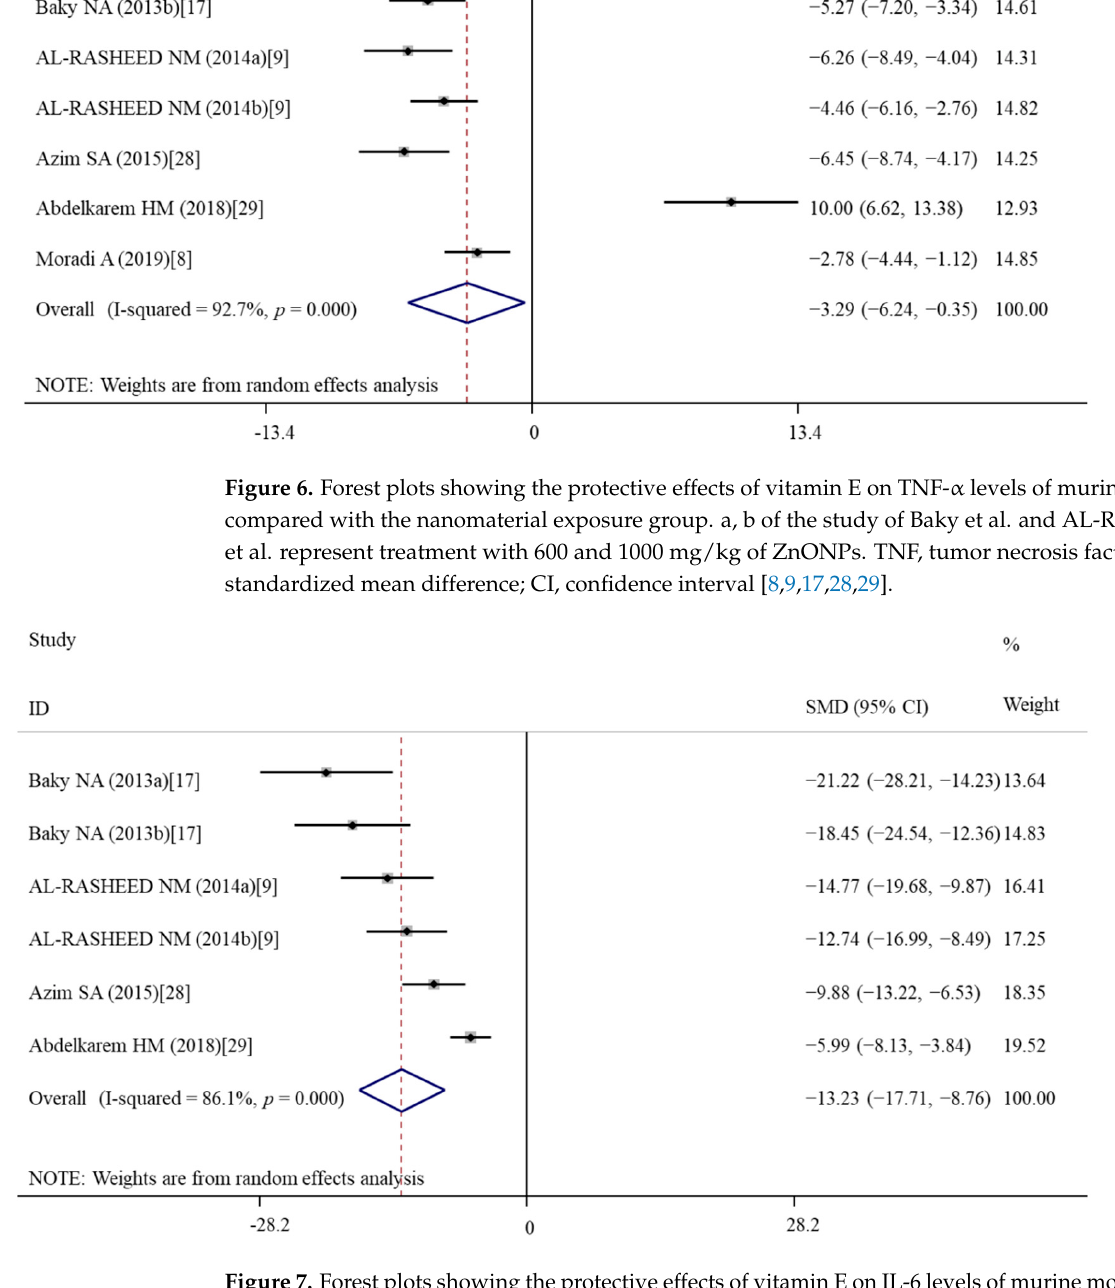
Figure 7. Forest plots showing the protective effects of vitamin E on IL-6 levels of murine models com- pared with the nanomaterial exposure group. a, b of the study of Baky et al. and AL-RASHEED et al. represent treatment with 600 and 1000 mg/kg of ZnONPs. IL, interleukin; SMD, standardized mean difference; CI, confidence interval